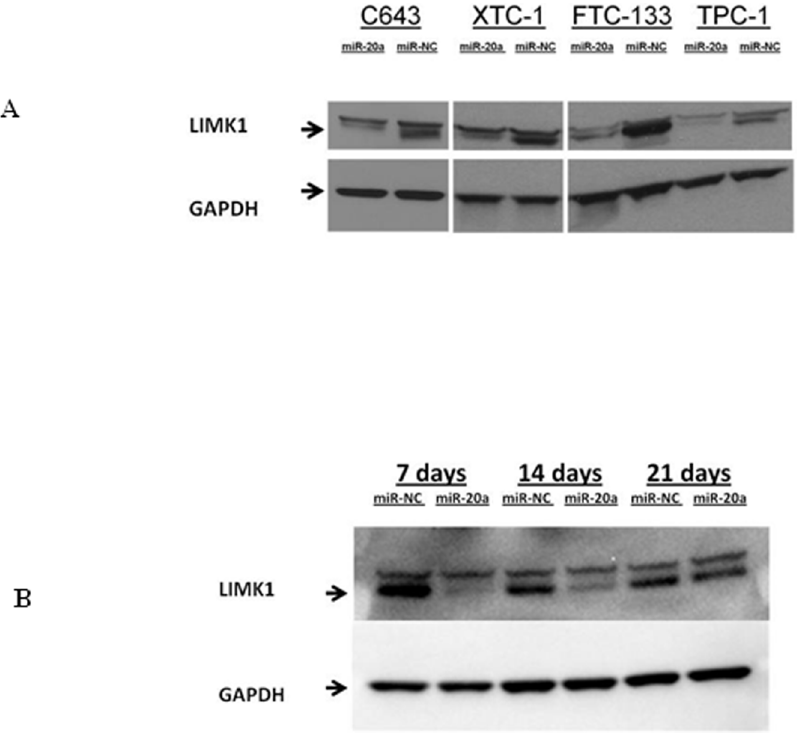
Figure 5. MiR-20a overexpression decreases LIMK1 protein expression in thyroid cancer cell lines. ( A ) Immunoblots for LIMK1 protein expression in C643, XTC-1, FTC-133, and TPC-1 cell lines, which were transfected with either miR-20a or miR-NC for 72 hours. ( B ) Immunoblots for